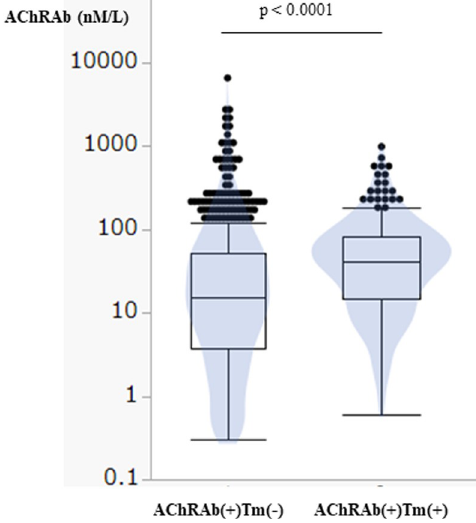
Fig 4. Maximum AChRAb titer of AChRb(+)Tm(-) and AChRAb(+)Tm(+). Box and violin plots of maximum titer of AChRAb of anti-acetylcholine receptor antibody (AChRb) (+) thymoma (Tm) (-) and AChRAb(+)Tm(+). The horizontal line within the box represents the median value. The box ends to define the 25th and 75th quantiles, also expressed as the first and third quartiles, respectively. The lines that extend from the box end are whiskers. The whiskers extend from the ends of the box to the outermost data point that falls within these distances. 1st quartile–1.5 x (interquartile range), 3rd quartile+1.5 x (interquartile range). For statistical analysis, we used Wilcoxon-Mann- Whitney test